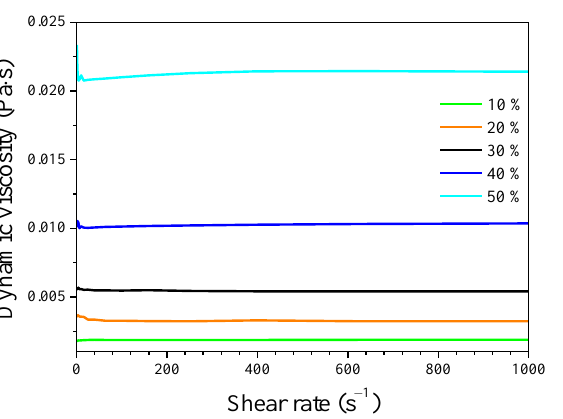
Figure 1. Viscosity of siloxane solutions in absolute ethanol (concentrations 10, 20, 30, 40, 50%).